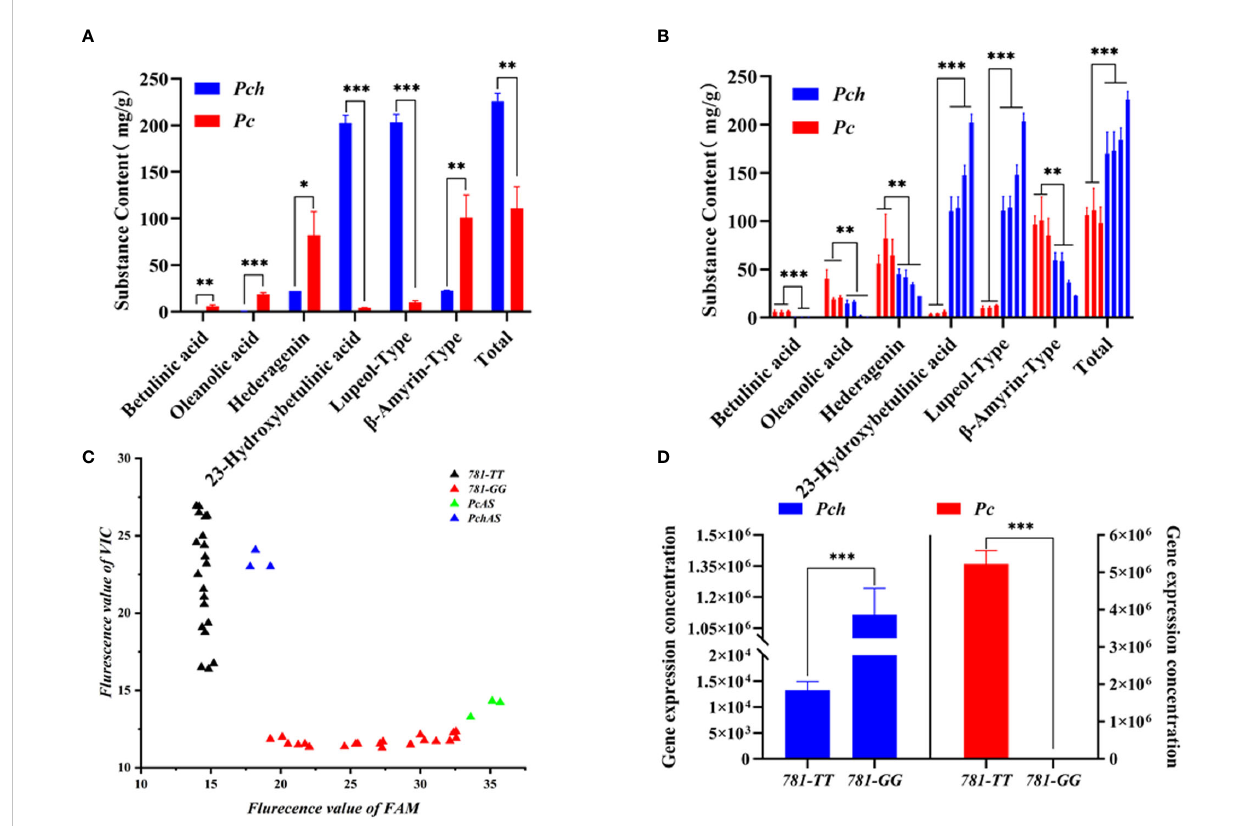
FIGURE 5 Triterpene acid content, PcAS and PchAS type gene expression in Pulsatilla ceruna and P. chinensis . (A) Different type triterpene acid contents in P. ceruna and P. chinensis freeze-drying roots, respectively; (B) Different type triterpene acid contents in P. ceruna and P. chinensis decoction pieces, respectively; (C) The FAM and VIC fl uorescent value of qPCR which P. ceruna , P. chinensis , plasmid pET32a- PcAS and plasmid pET32a- PchAS as template; (D) Absolute gene expression of PcAS and PchAS type in P. ceruna and P. chinensis , 781- TT and 781- GG represent PchAS and PcAS type